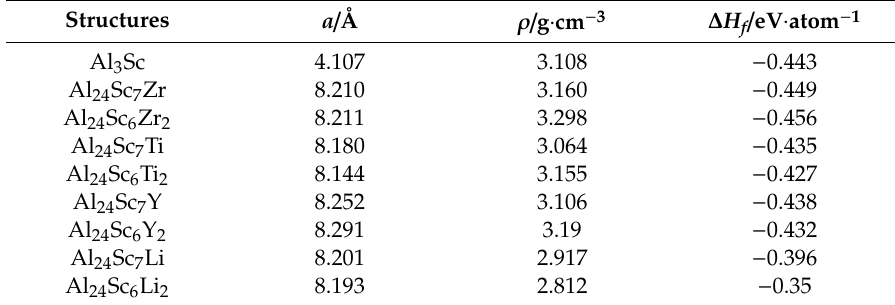
Table 1. The crystal parameters (Å), density ( ρ / g · cm − 3 ), and heat of formation ( ∆ H f / eV · atom − 1 ) of L1 2 -Al 3 Sc 1– x M x at the ground state.